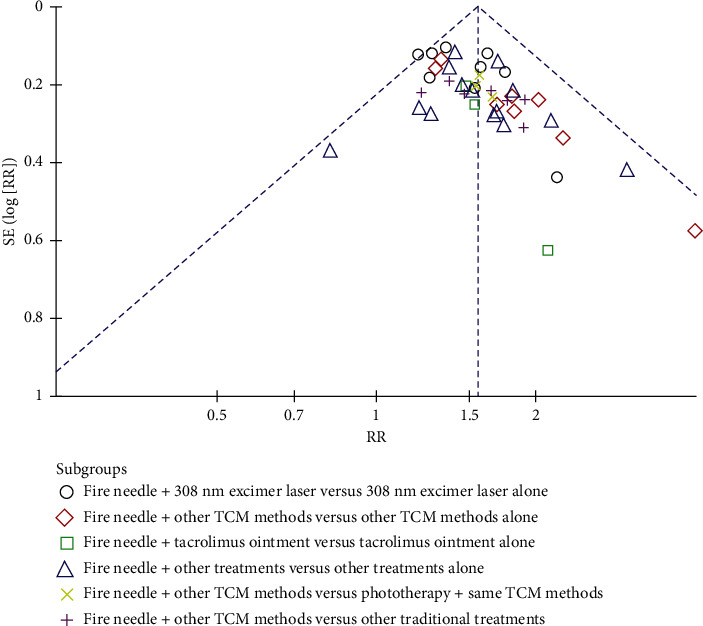
Funnel plot of the total effectiveness rate according to the NP formula. TCM, traditional Chinese medicine; NP formula, effectiveness rate = (the number of cured patients + the number of markedly effective patients)/the number of total patients × 100%.